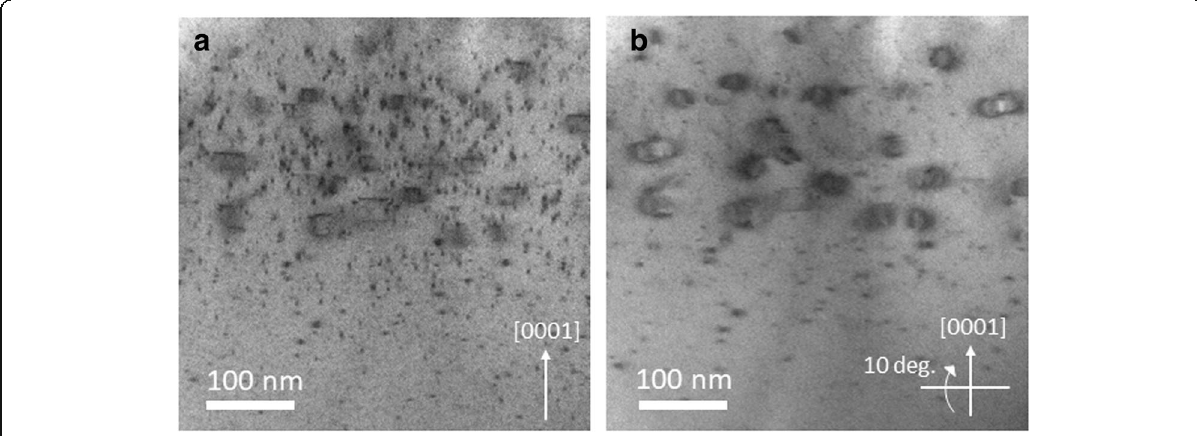
Fig. 3 a Cross-sectional bright field STEM image of Mg-implanted bulk GaN sample for analyzing type B defects which appear like truncated pyramids or trapezoidal shape. b represents the image taken by tilting the sample at 10° around the axis perpendicular to c -axis where a different contrast is observed at the edges of these